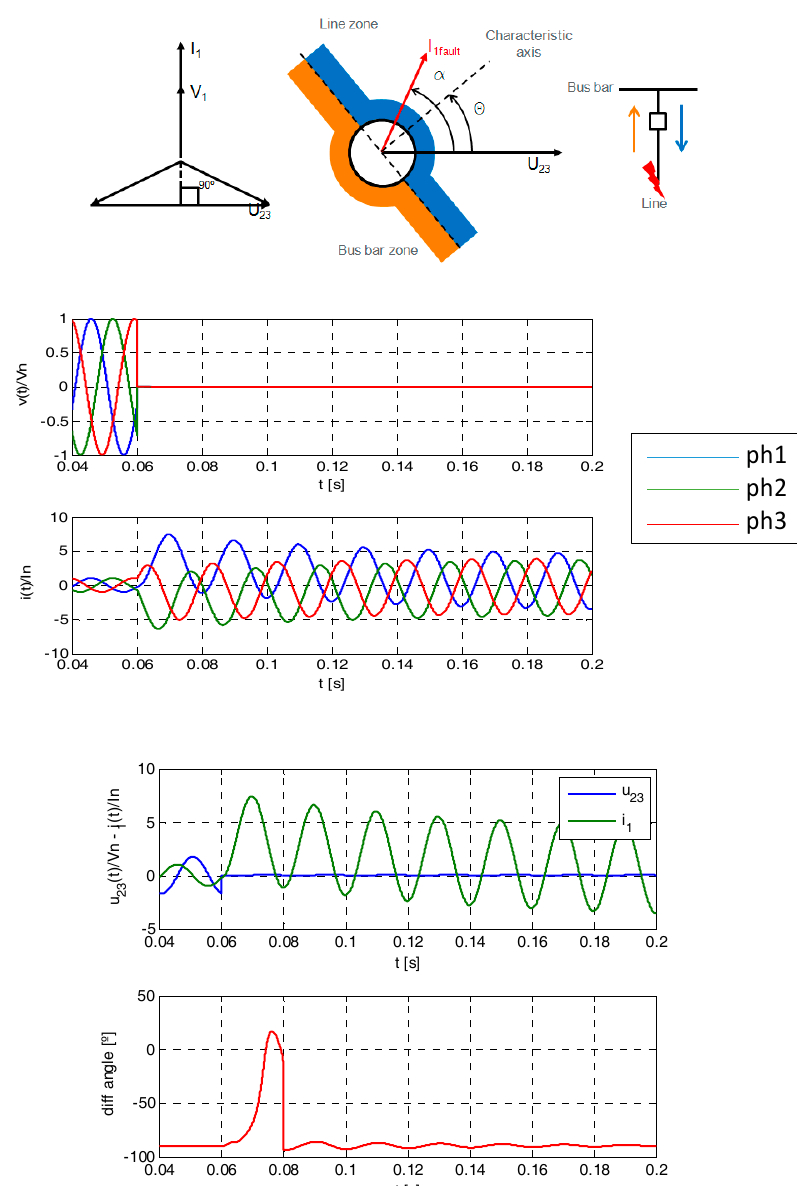
Figure 2. Phase fault detection and waveforms.